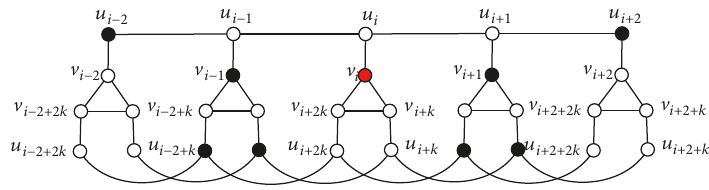
Figure 2: The set of black vertices is 𝑁 3 (𝑤) for 𝑤 = V 𝑖